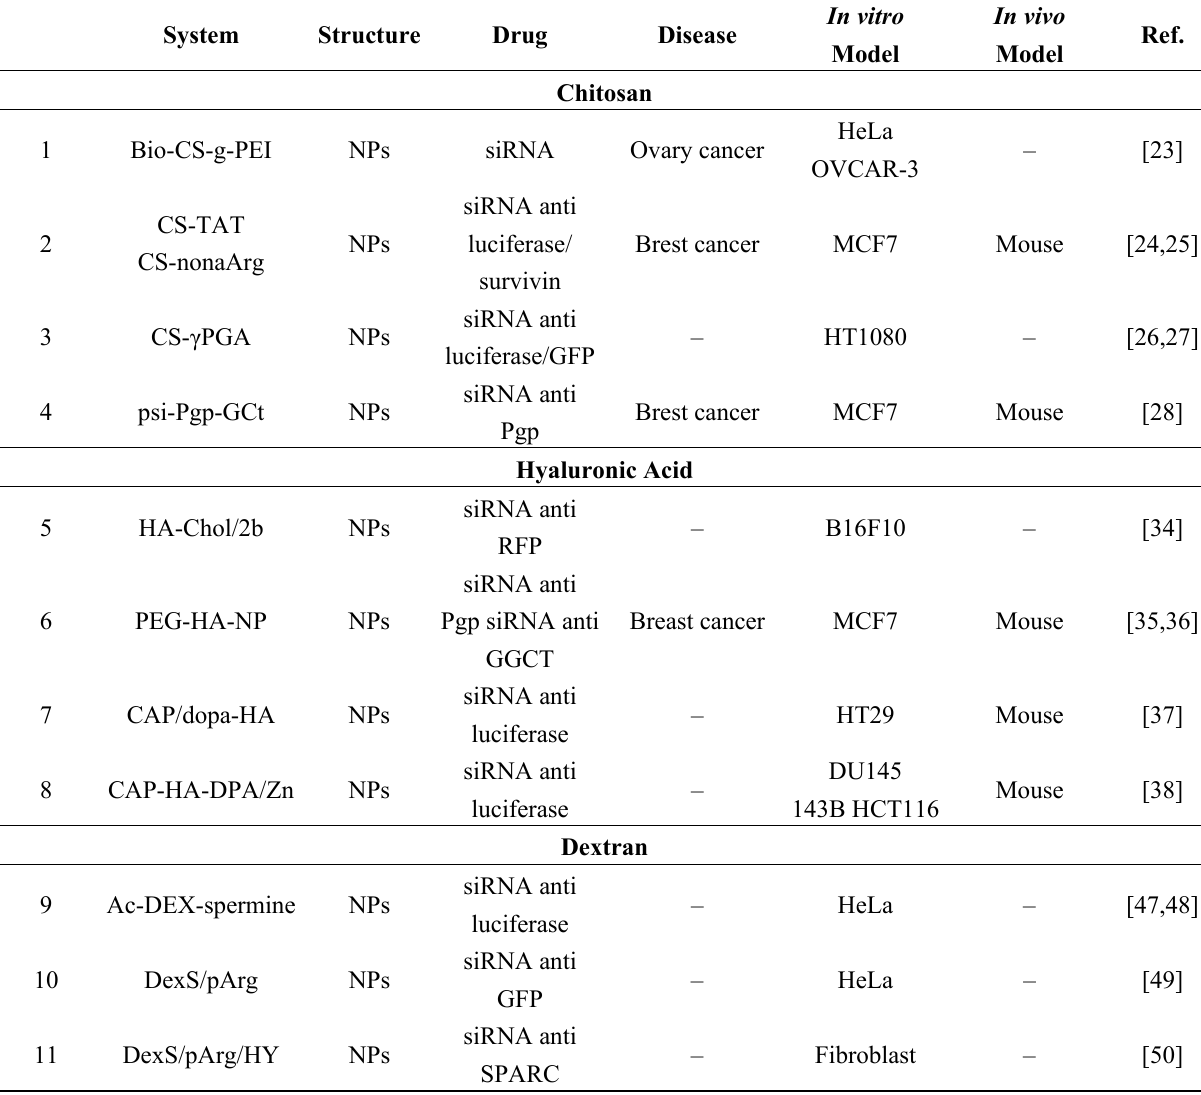
Table 3. Polysaccharide-based delivery of